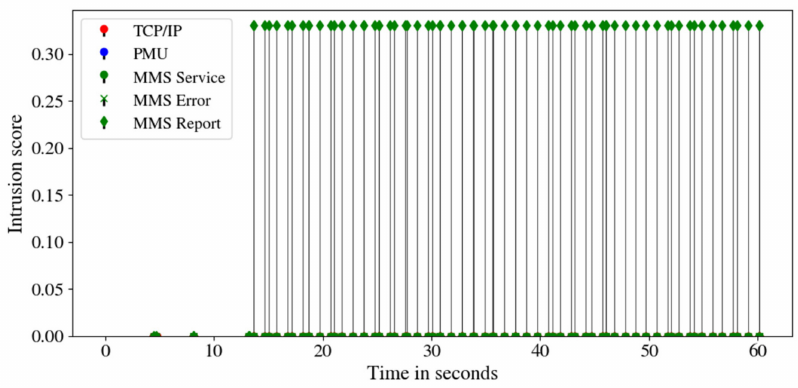
Figure 9. Intrusion scores of the specification-based NIDS for a corrupted MMS report communication.